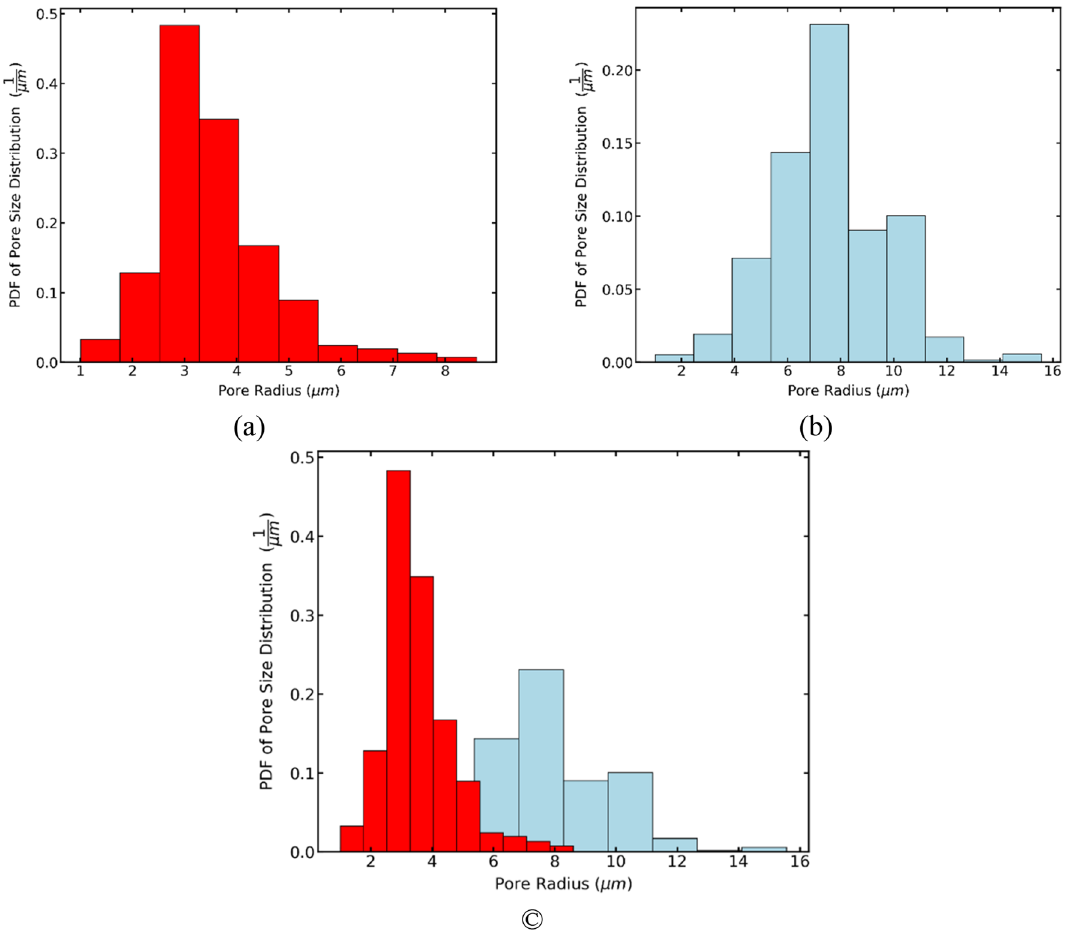
Figure 17. Histograms of probability density function (PDF) of the pore size distribution (PSD) for porous media with porosity of 0.5 and sigma of 2.0 ( a ) and 1.0 ( b ). A comparison between the two different sigma values ( c ).